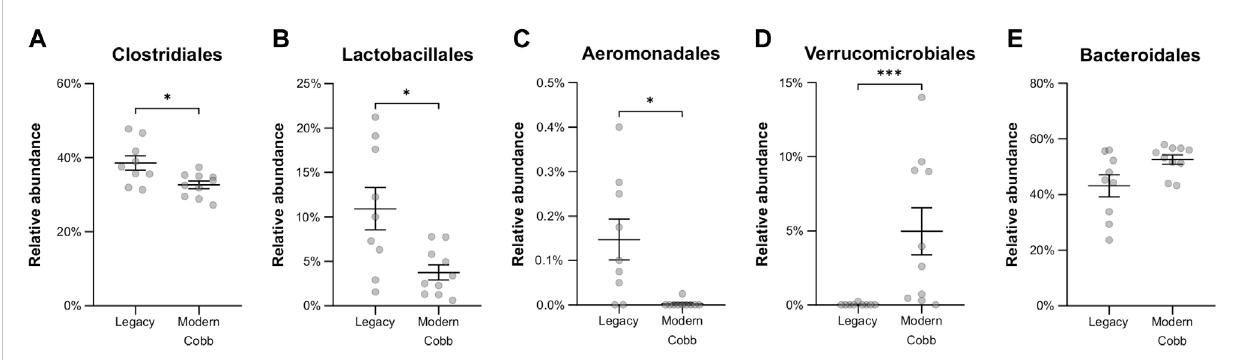
FIGURE 6 Relative abundance of orders that were signi fi cantly different between the Legacy and Cobb lines. (A) Clostridiales (B) Lactobacillales (C) Aeromonadales (D) Verrucomicrobiales (E) Bacteroidales. Data are presented as mean ± SEM. Legacy n = 9, Cobb n = 10; Mann-Whitney test; * p ≤ 0.05, *** p ≤ 0.001.